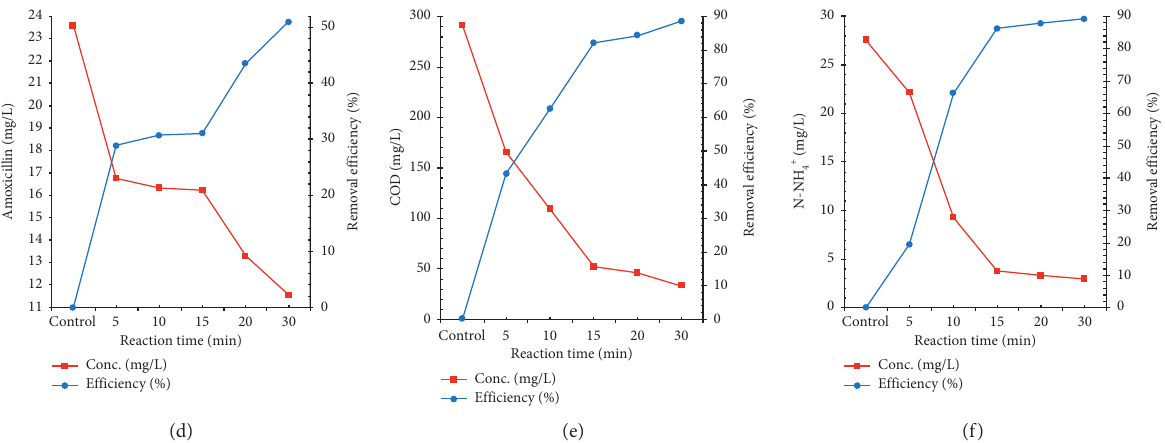
Figure 3: Effect of the reaction time on the degradation efficiency of four antibiotics, namely, (a) ofloxacin, (b) ciprofloxacin, (c) cefuroxime, and (d) amoxicillin, respectively, as well as (e) COD and (f) ammonia